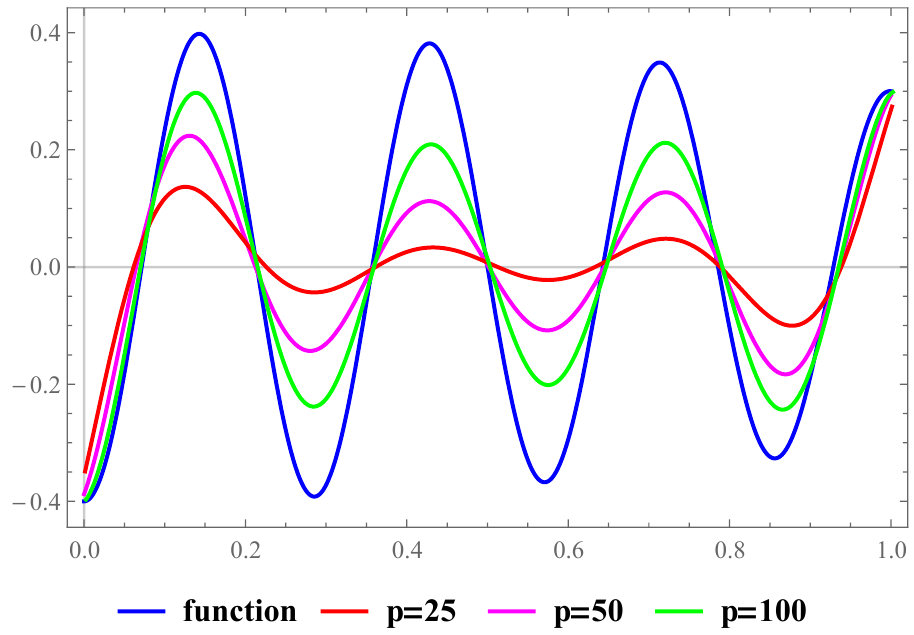
( α , s ) for function r 1 ( u ) p , λ